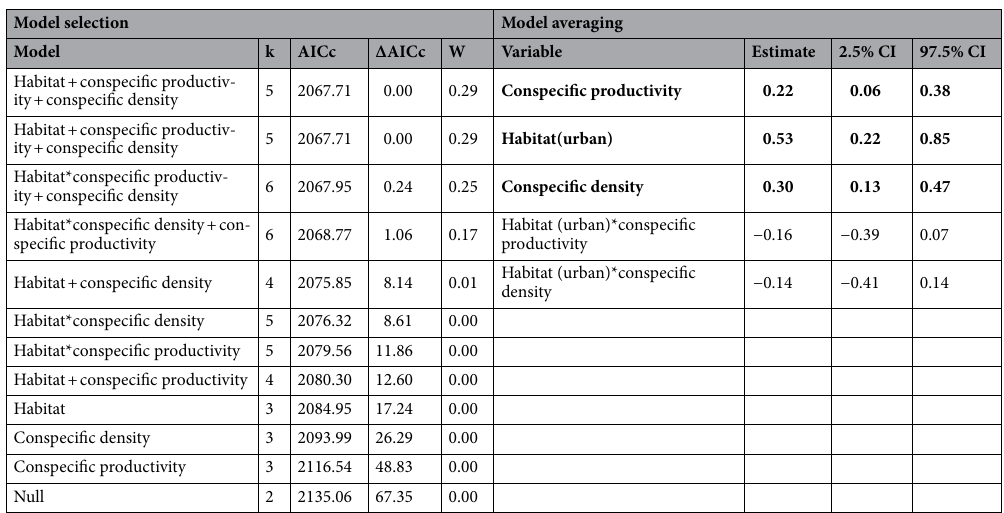
Table 1. Models obtained to assess the effects of habitat, conspecific density, and productivity on the probability of a breeding site being occupied by a family unit of burrowing owls Athene cunicularia . Estimates and 95% confidence intervals (2.5% and 97.5%) were assessed after model averaging. All models were run including year as a random term. k: number of parameters, AICc: Akaike Information Criterion corrected for small sample sizes, ΔAICc: difference between the AICc of model i and that of the best model (i.e. the model with the lowest AICc), w: Akaike weights. The fit of the model including all variables used in model averaging can be checked in Fig. S2. In bold, variables receiving strong support (i.e., the 95% confidence interval did not overlap with